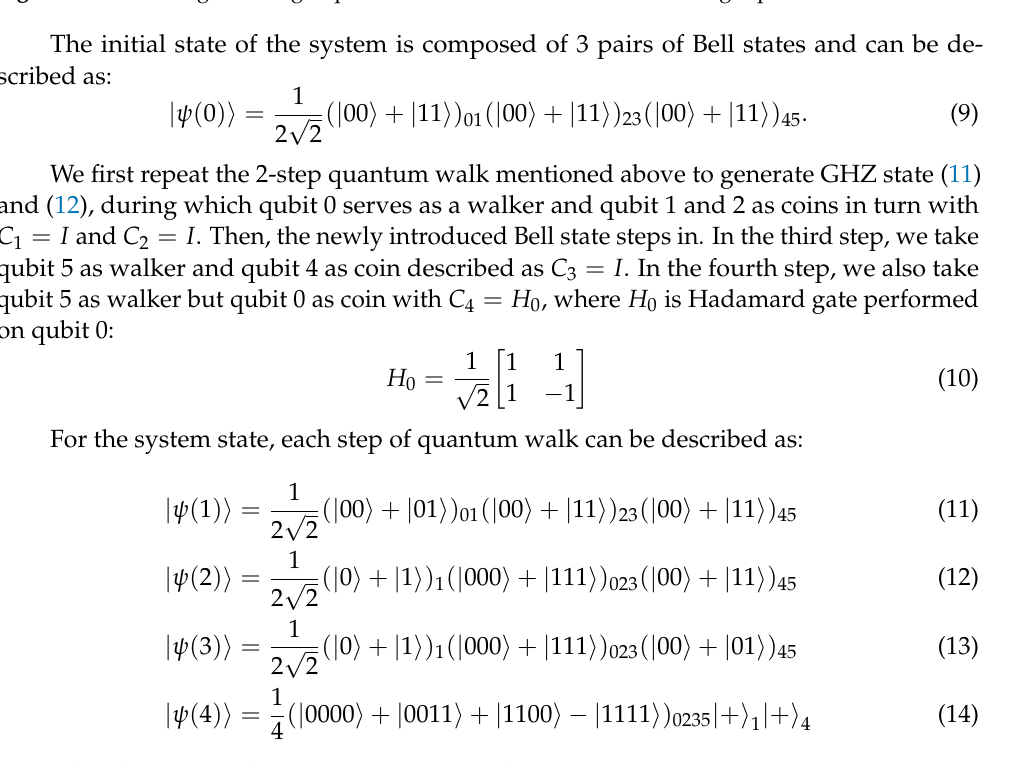
Figure 3. Process of generating 4-qubit cluster state with Bell states through quantum